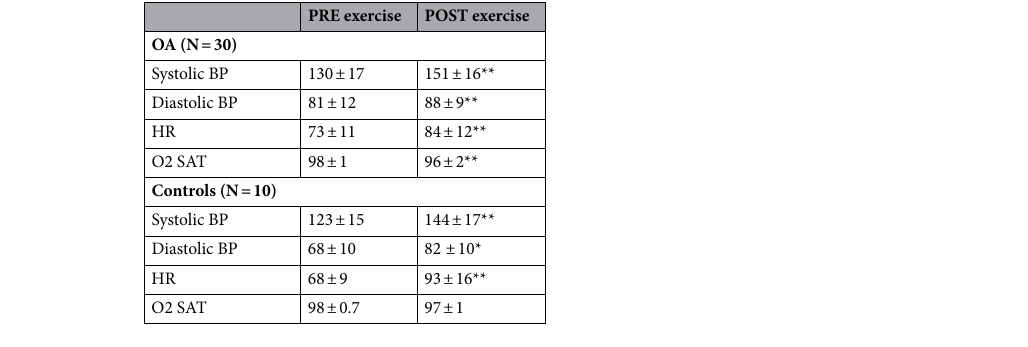
Table 1. Pre- and post-activity physiological measurements. *p < 0.05. **p < 0.01.